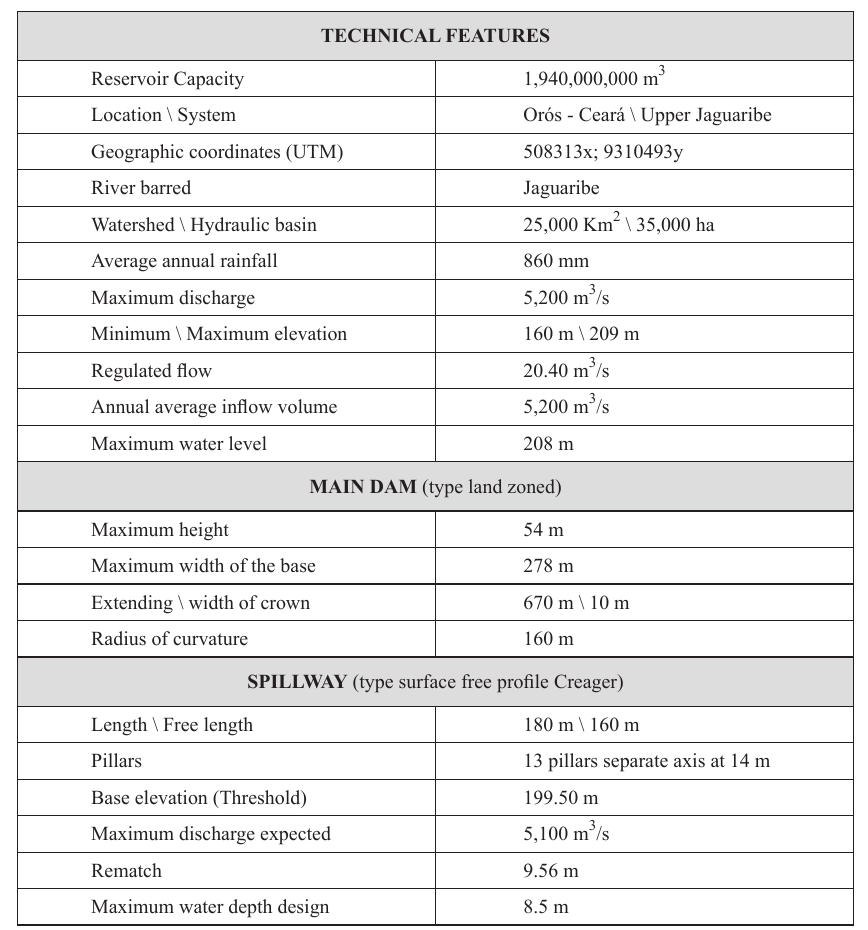
Technical features of dam Orós (Araújo